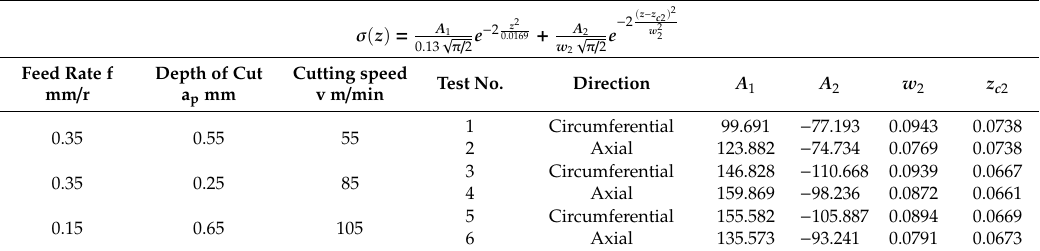
Table 7. Predicted residual stress profile functions.